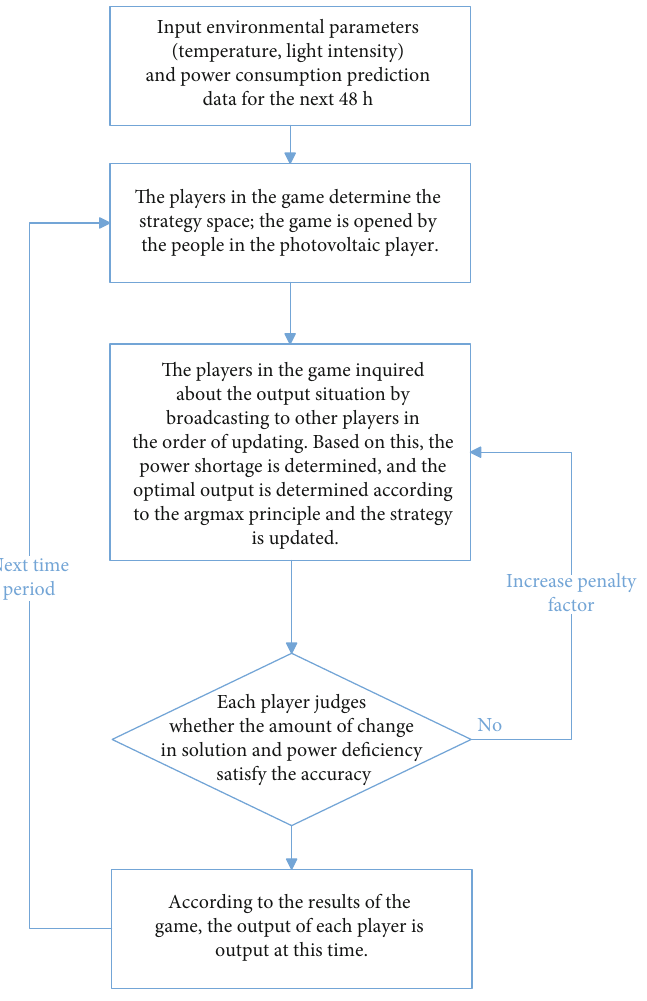
Figure 2: The fl ow chart of game